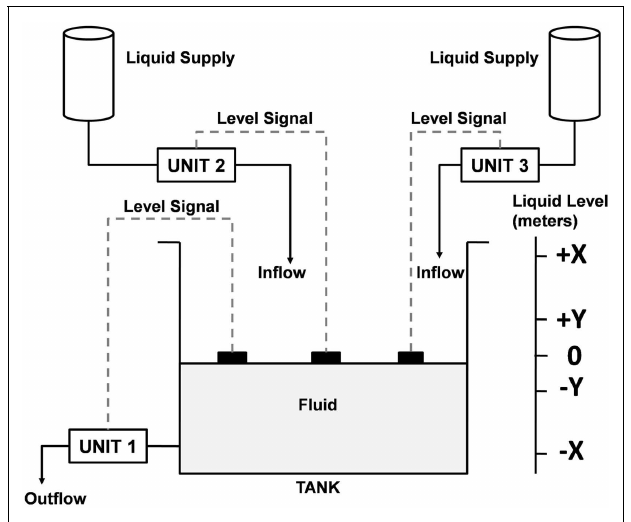
FIGURE 3 | Hold-up tank (Benchmark problem)